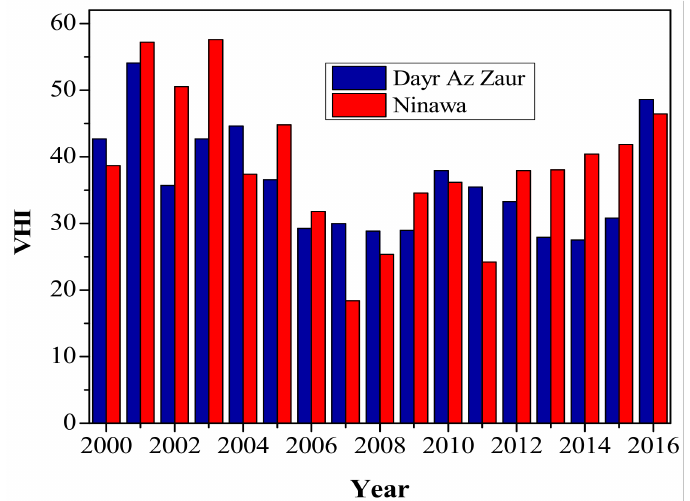
Figure 6. Spatial-averaged annual VHI values in the Ninawa province in Iraq and the Dayr Az Zawr province in Syria from 2000 to